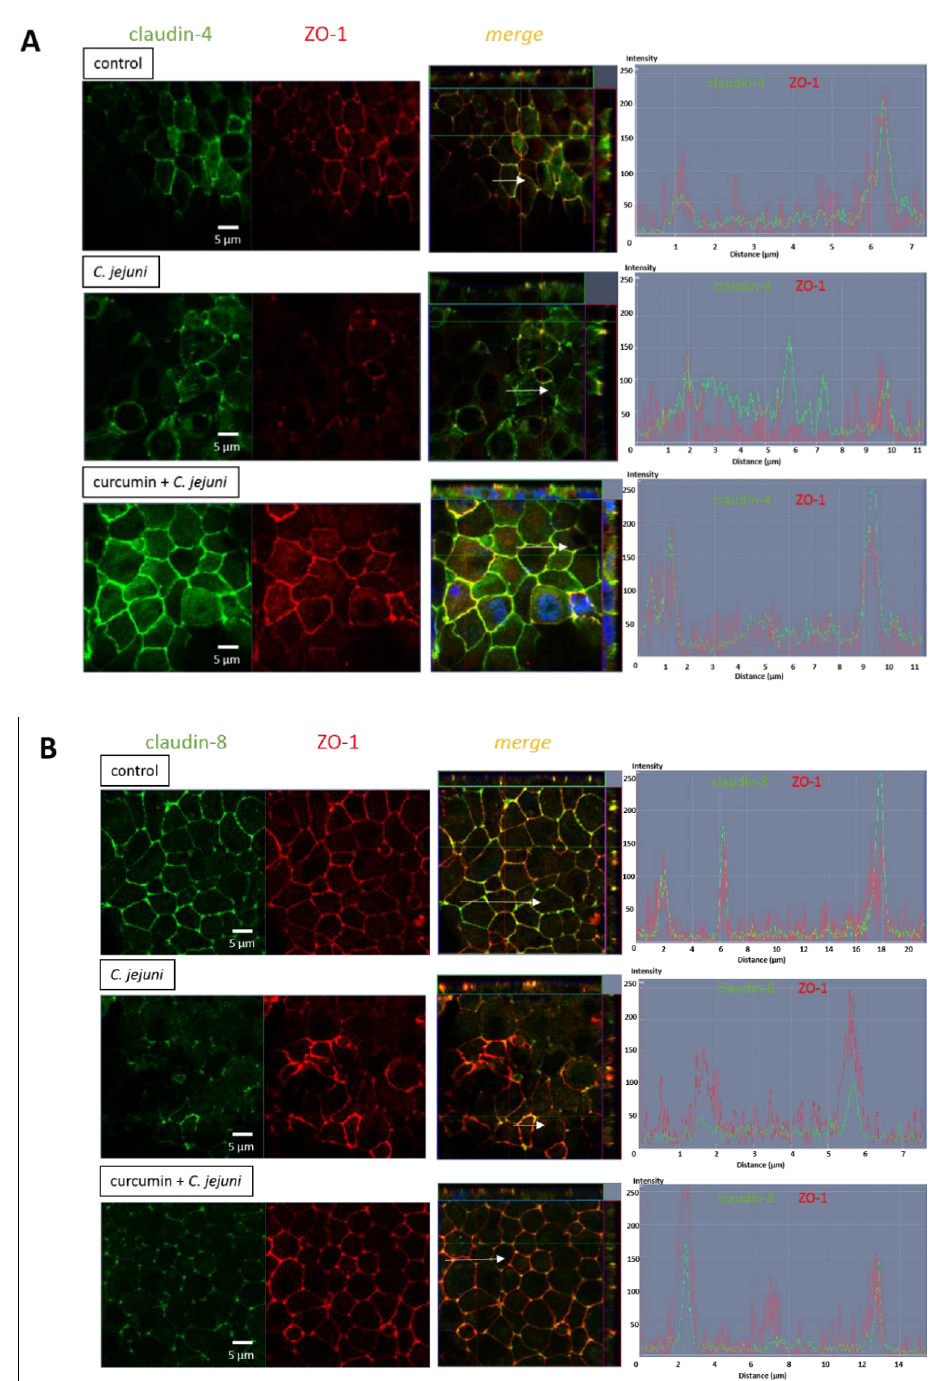
Figure 9. Tight junction distribution in C. jejuni infection after treatment with curcumin. Representative confocal laser-scanning microscopy pictures of HT-29 / B6-GR / MR after co-culturing together with immune cells. ( A ) Claudin-4 (green) and zonula occludens protein-1 (ZO-1, red), and ( B ) claudin-8 (green) and ZO-1 (red). Nuclei are stained in blue with 4´-6-diamidino-2-phenylindole dihydrochloride (DAPI).